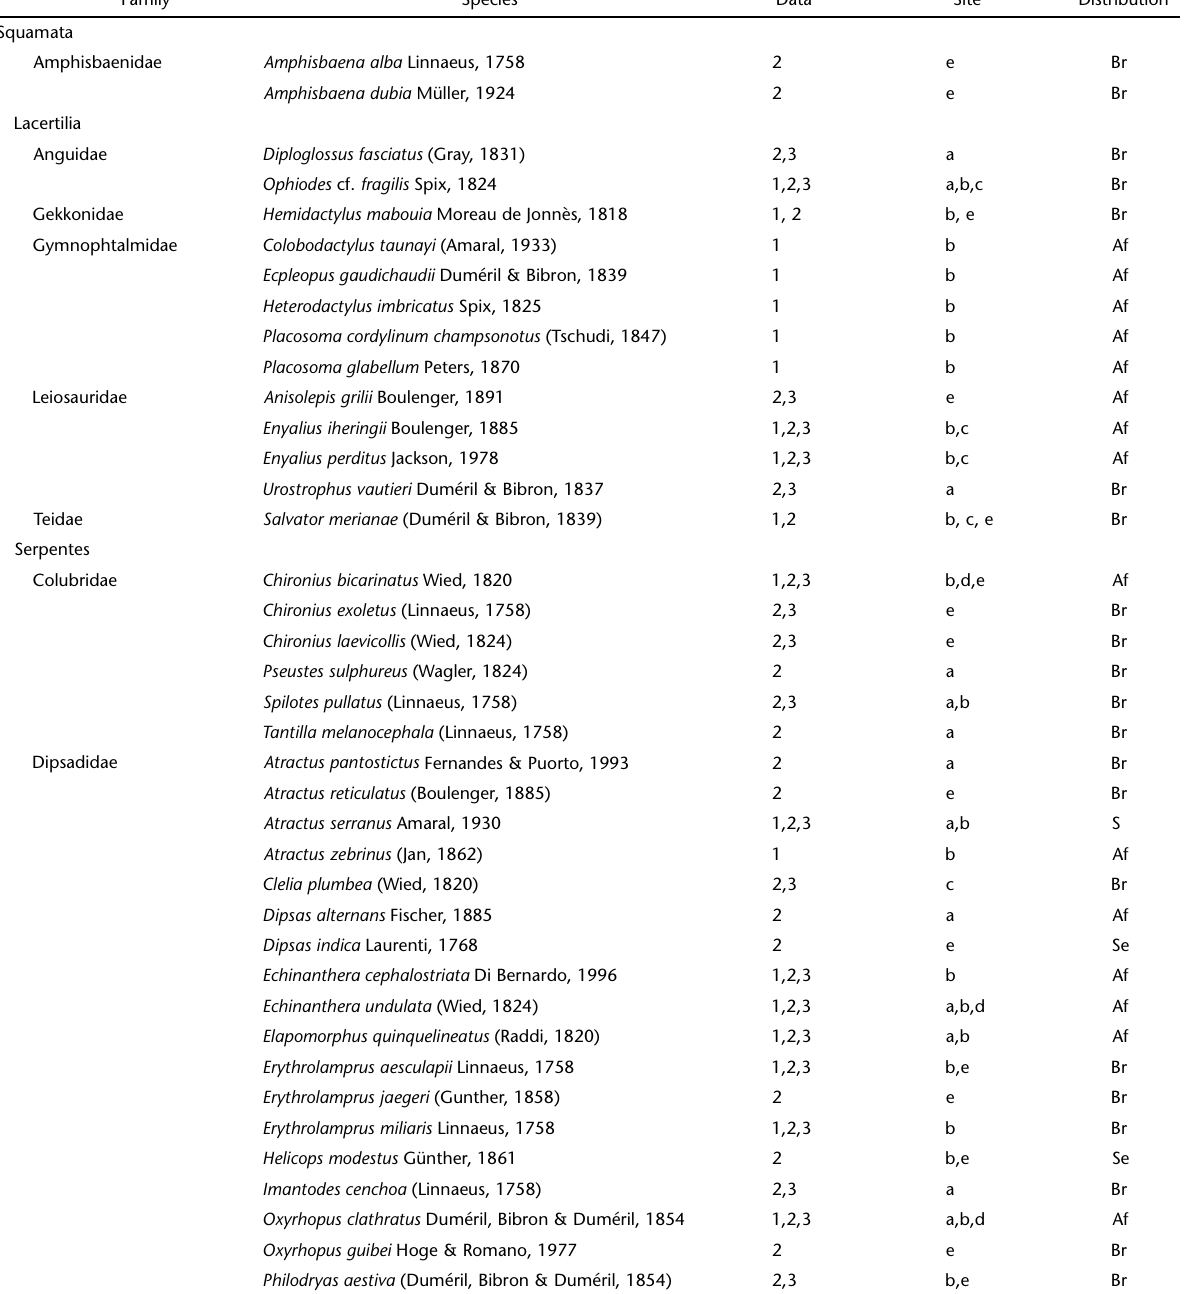
Table II. Species composition of reptiles from Parque Municipal Nascentes de Paranapicaba, Santo André, São Paulo (PNMNP). Type of data collected: 1. Primary data from field surveys during the study period, 2. secondary data gathered from herpetological collection catalogs, 3. secondary data from Marques (2009). Localities of occurrence at site areas: a. Paranapiacaba or Alto da Serra, b. PNMNP (study area), c: Reserva Biológica do Alto da Serra de Paranapicaba, d: Campo Grande da Serra, e: Santo André and adjacent municipalities. Geographical distribution: Par: species exclusive to Paranapiacaba region, S: endemic for the Serra do Mar from São Paulo state, Se: Serra do Mar formation, south and southeastern Brazil, Af: broad distribution within the Atlantic forest, Br: broad distribution in Brazil. Family Species